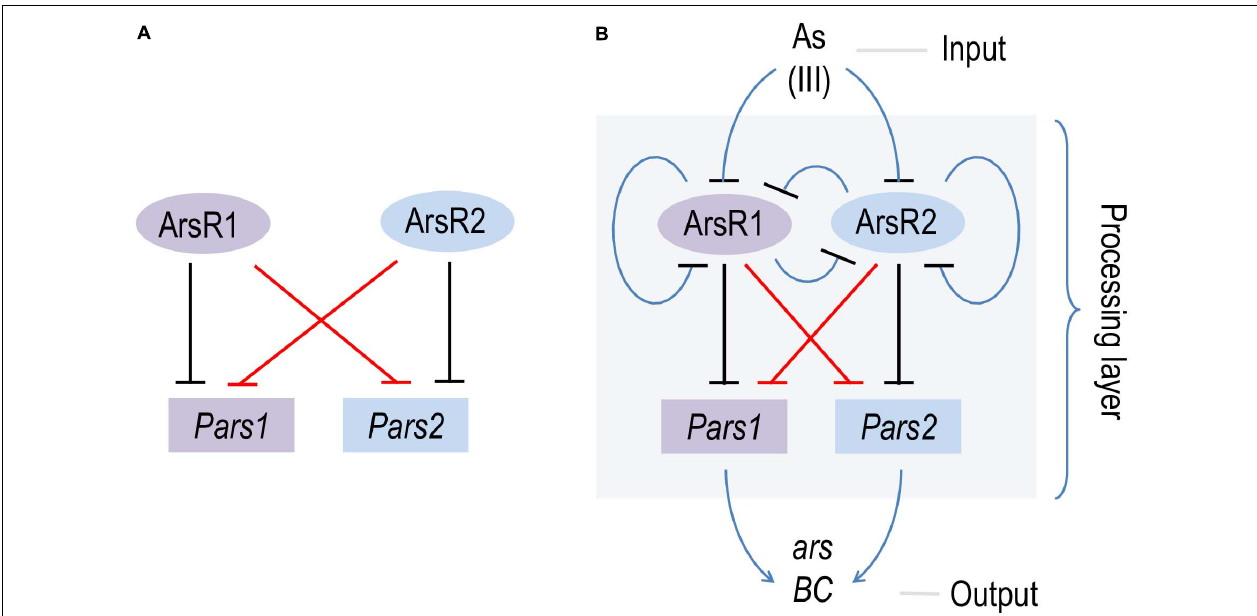
FIGURE 7 | Scheme of the bifan network cross-regulation between ars1 and ars2 operons in Pseudomonas putida KT2440. (A) Basic scheme of the bifan network where ArsR1 and ArsR2 repress their own promoters Pars1 and Pars2 (black lines) and the each other (red lines). (B) Processing layer of the bifan network operated by direct and lateral inverter steps (blue lines) where the presence of AsIII (input) is translated in the expression of the resistance genes arsB and arsC